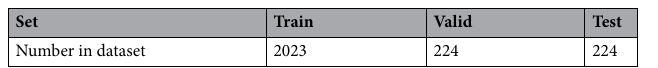
Table 3. Merged dataset train, validation, and test split breakdown.